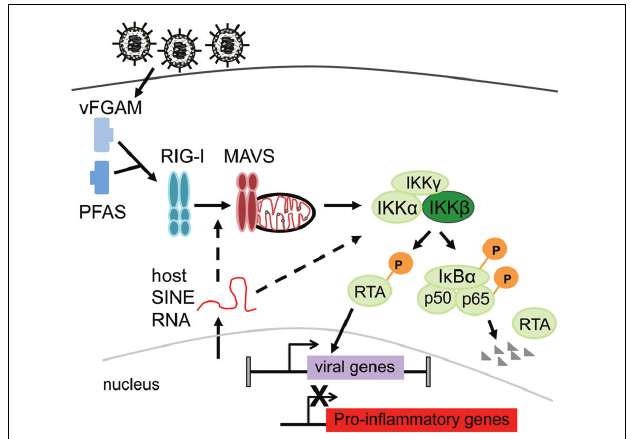
FIGURE 5 | Model for the role of canonical NF- κ B signaling in productive infection. Model summarizing recent reports of virus interplay with canonical NF- κ B signaling to promote productive infection. Viral tegument protein (vFGAMS/vGAT) encoded by ORF75C and host SINE RNAs induced by infection leads to IKK β activation and phosphorylation of RTA (Dong and Feng, 2011; He et al., 2015; Karijolich et al., 2015). Phosphorylation of RTA increases transactivation of viral genes (Dong and Feng, 2011). RTA targets NF- κ B subunit p65 for degradation to